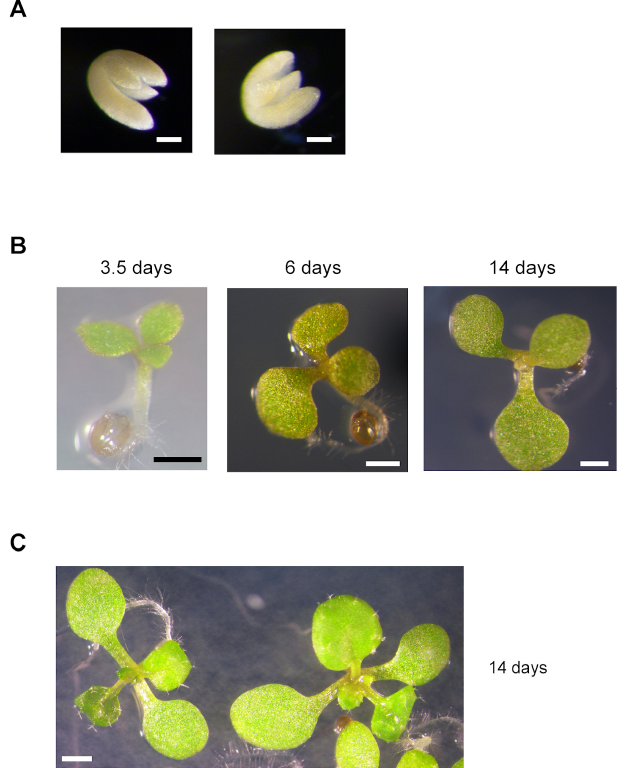
Figure 3. Presence of 3-cotyledon embryos in abnormal seeds. ( A ) Manually extracted mature embryo (two views) from a MIT1mit1 mit2mit2 plant. ( B ) Abnormal seeds from mit1mit1 MIT2mit2 plants were sown on 0.5 × MS, stratified for 48 h, and grown for 3.5, 6, and 14 days. The same plant bearing three cotyledons was photographed. ( C ) Control wild type plants grown for 14 days. Bars = 100 µ m in ( A ), 500 µ m in ( B ), and 1000 µ m in ( C